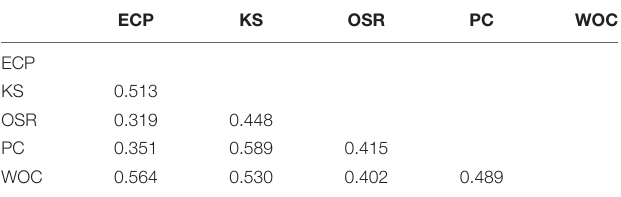
TABLE 3 | Heterotrait–Monotrait (HTMT)